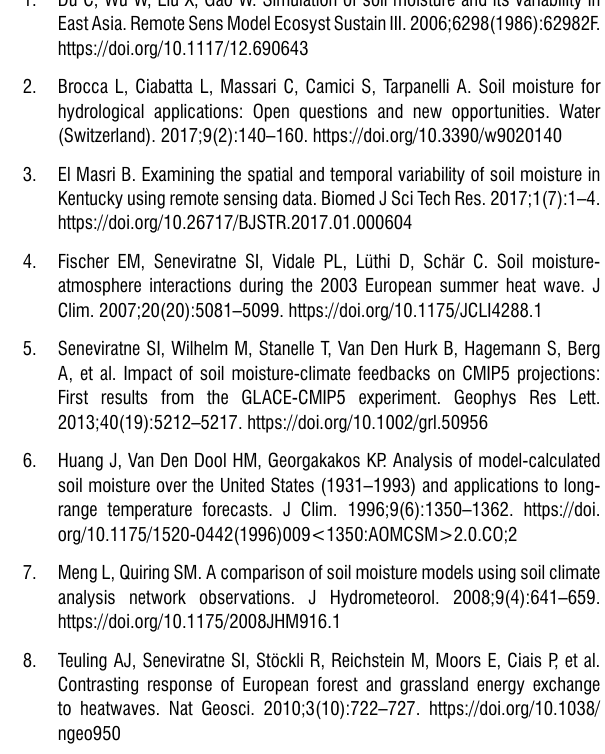
), annual rainfall and soil moisture over the last 39 recent years at different air